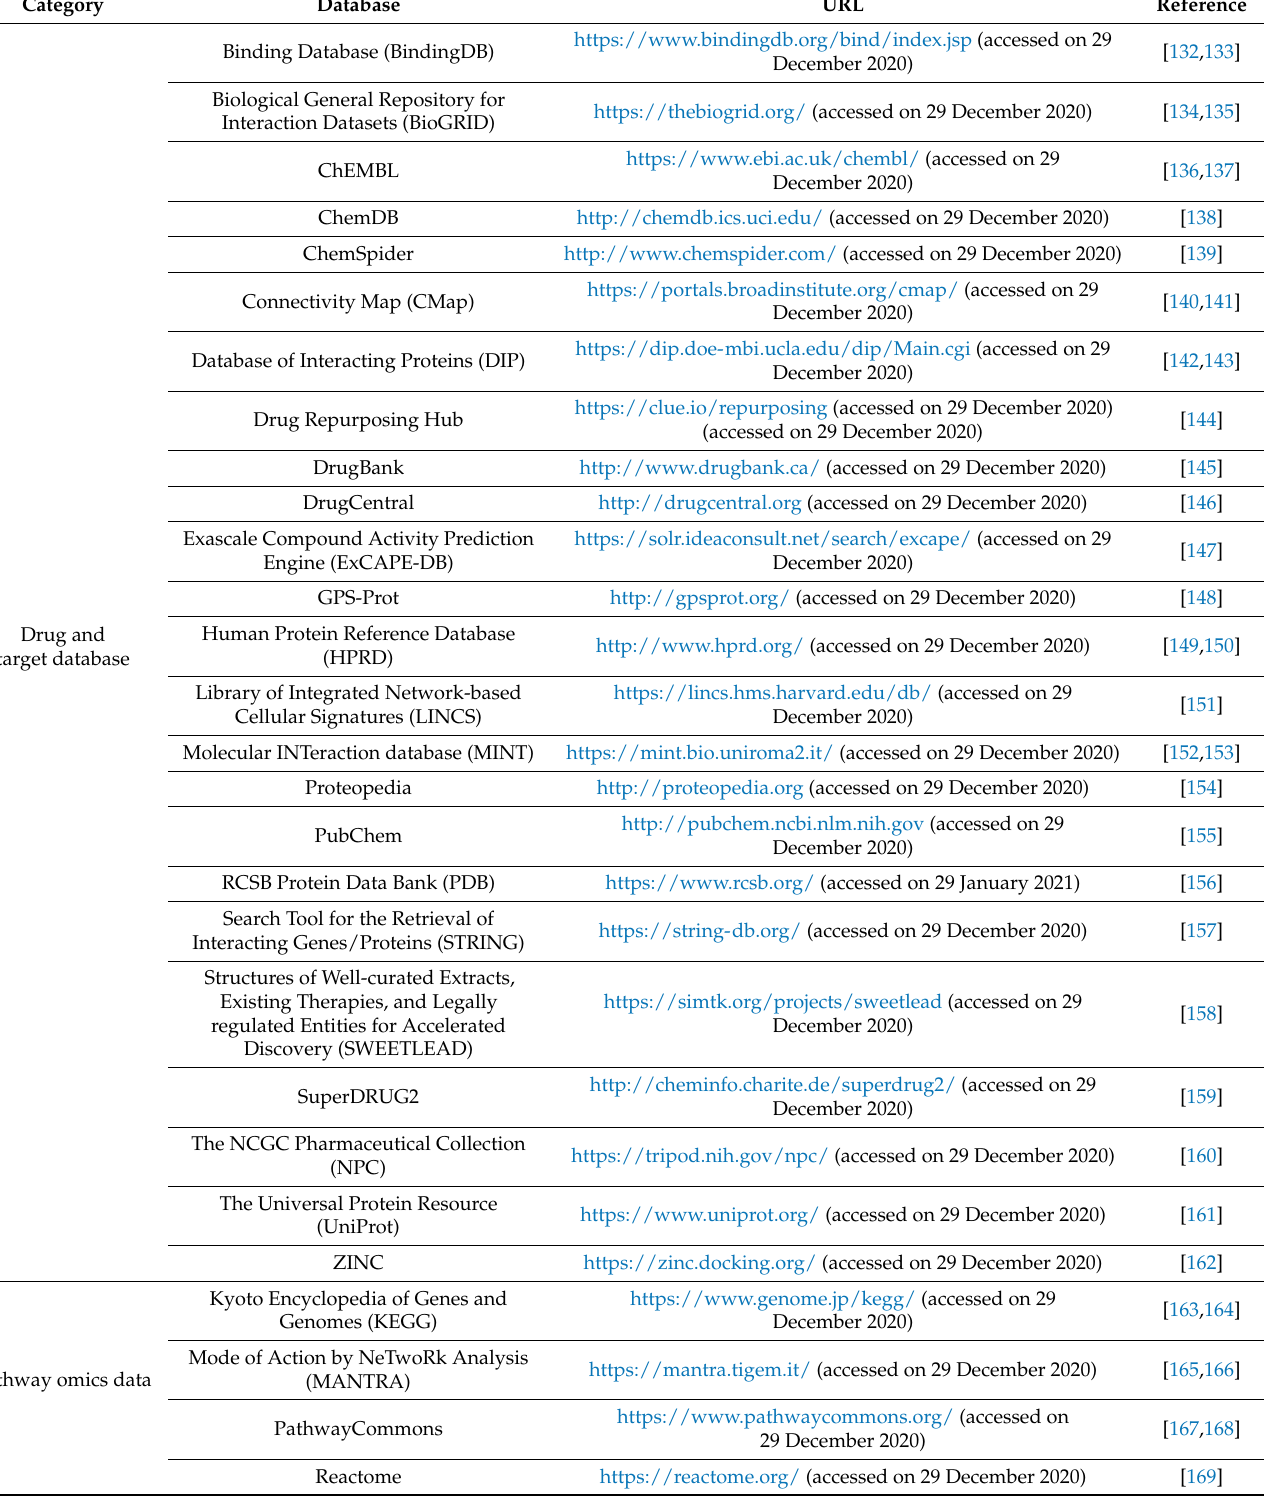
Table 2. List of databases that widely used for the in silico drug repurposing